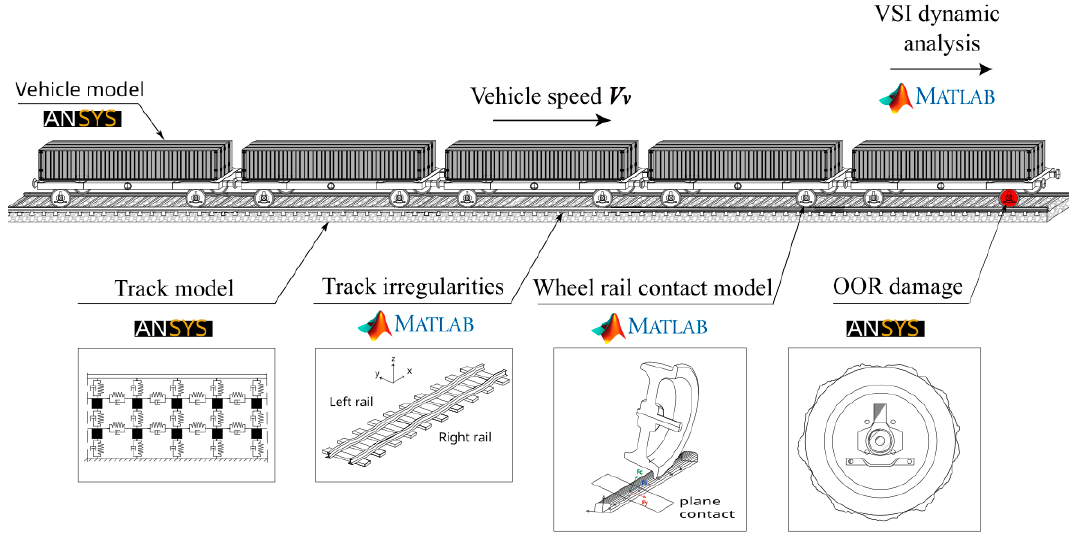
Figure 9. Graphical representation of the numerical modeling.